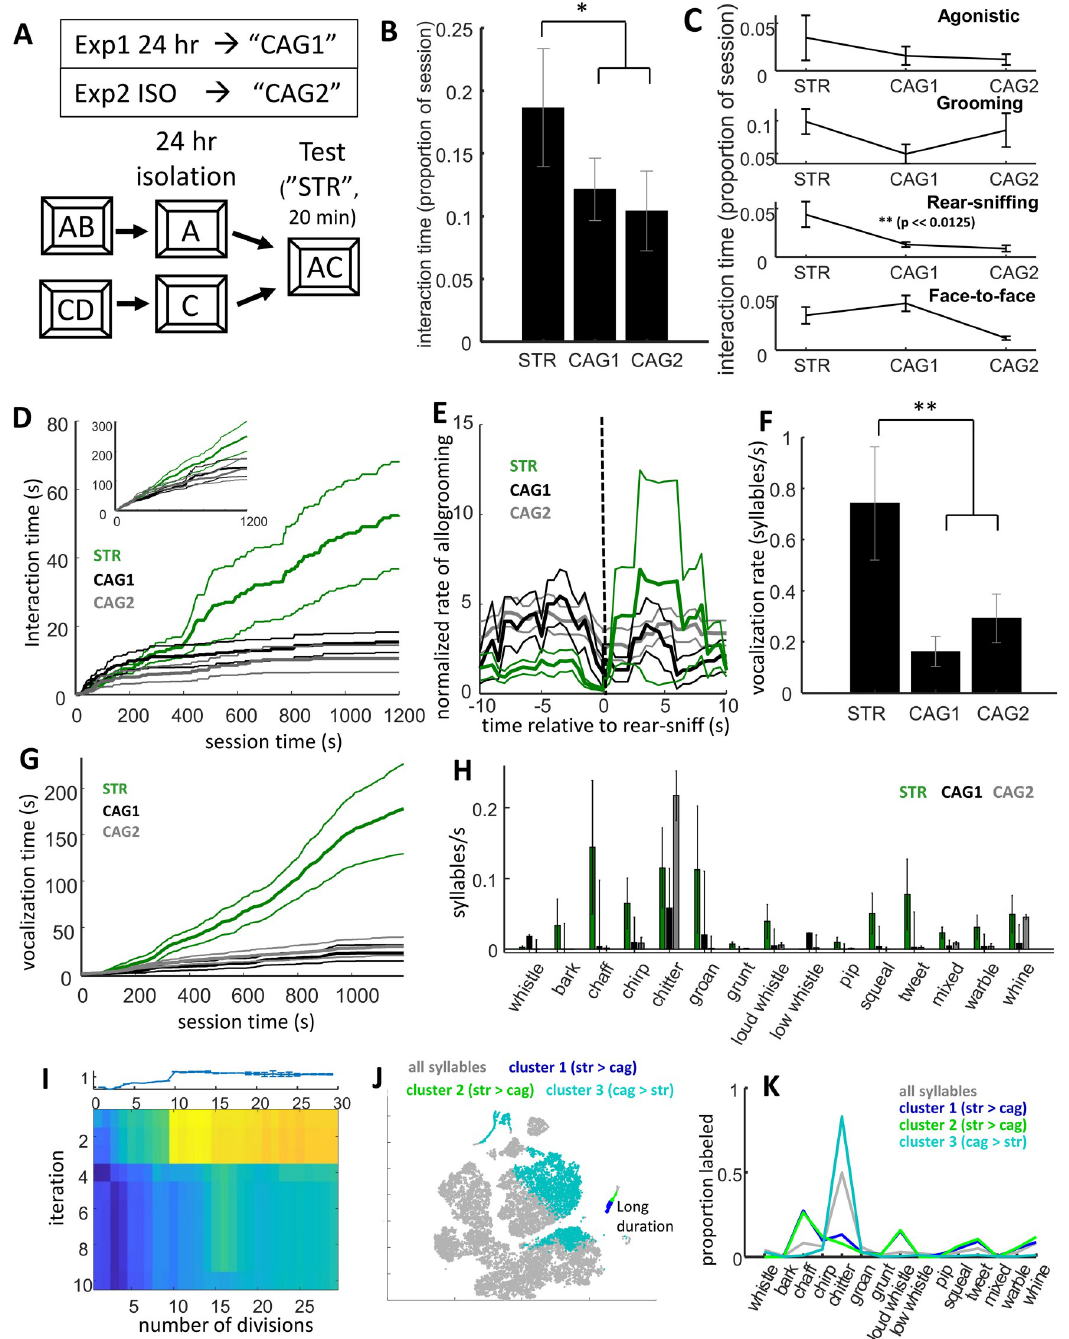
Fig 4. Comparison of social behavior between stranger and cagemate dyads. A) Illustration of protocol. Cagemates were isolated for 24 hour and then brought together with an unfamiliar conspecific. B) Proportion of time degus spent interacting. There was a statistical trend for stranger pairs to be more interactive than cagemates (STR = stranger, n = 8 dyads; CAG1 = cagemates Experiment 1, n = 9 dyads; CAG2 = cagemates Experiment 2, n = 8 dyads) C) Proportion of time dyads of each group engaged in different types of physical interaction. Although there was a pattern for higher levels of interaction between strangers across all types, a strong difference was only observed for rear-sniffing. D) Cumulative time dyads in each group spent engaged in rear-sniffing behavior (thicker lines are means, thin lines s.e.m.). Although rear-sniffing was common across all groups during the first several minutes, this behavior decreased among cagemates (CAG1 and CAG2, black and gray traces) but continued at high levels in strangers (STR, green trace). Inset shows cumulative interaction time across all interactive behaviors. E) Cross correlogram of levels